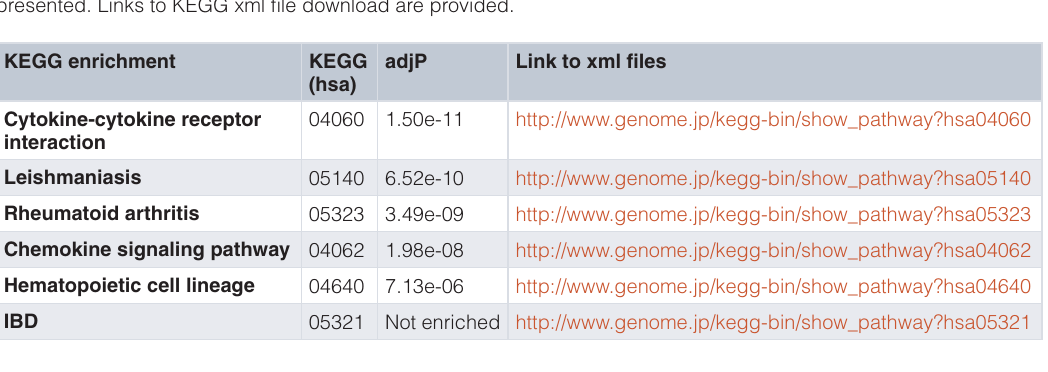
Table 2. Five top pathways enriched (adjP) in differentially expressed gene analysis 16 , in addition to inflammatory bowel diseases (IBD) pathway. Top human KEGG pathways were obtained and enrichment p-values presented. Links to KEGG xml file download are provided.